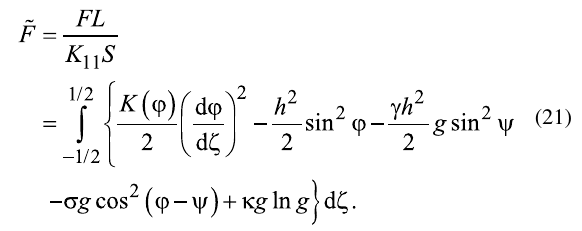
parameter σ takes large values, which corresponds to suffi- ciently strong anchoring of the CNTs and the NLC